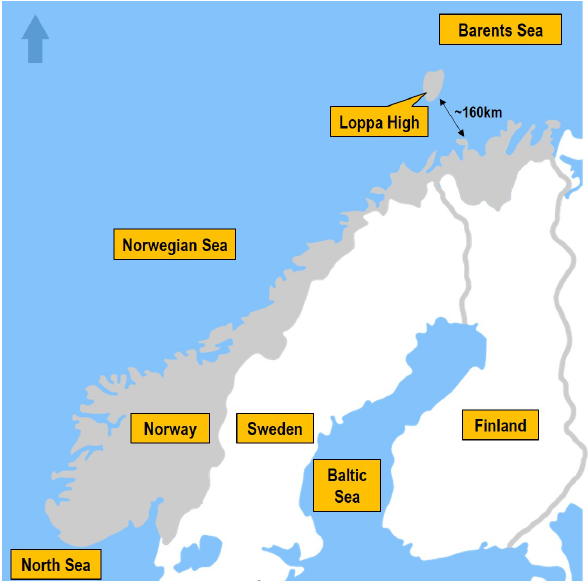
Figure 1. Barents Sea, Loppa High Region, Alta and Gohta